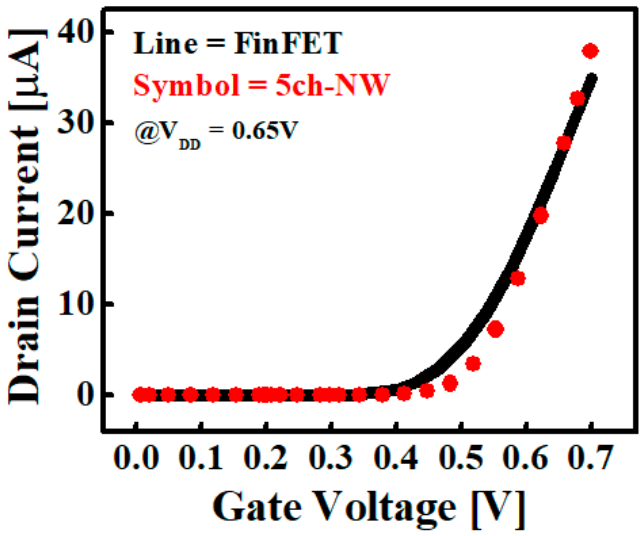
Figure 2. Black line is the I D -V G curve of the FinFET and the red symbol is the I D -V G curve of the 5ch-NW and shows the calibrated FinFET and 5ch-NW’s I D -V G curve characteristics for similar conditions. Both were extracted by sweeping V G from 0 to 0.7 V when V DD = 0.65 V.